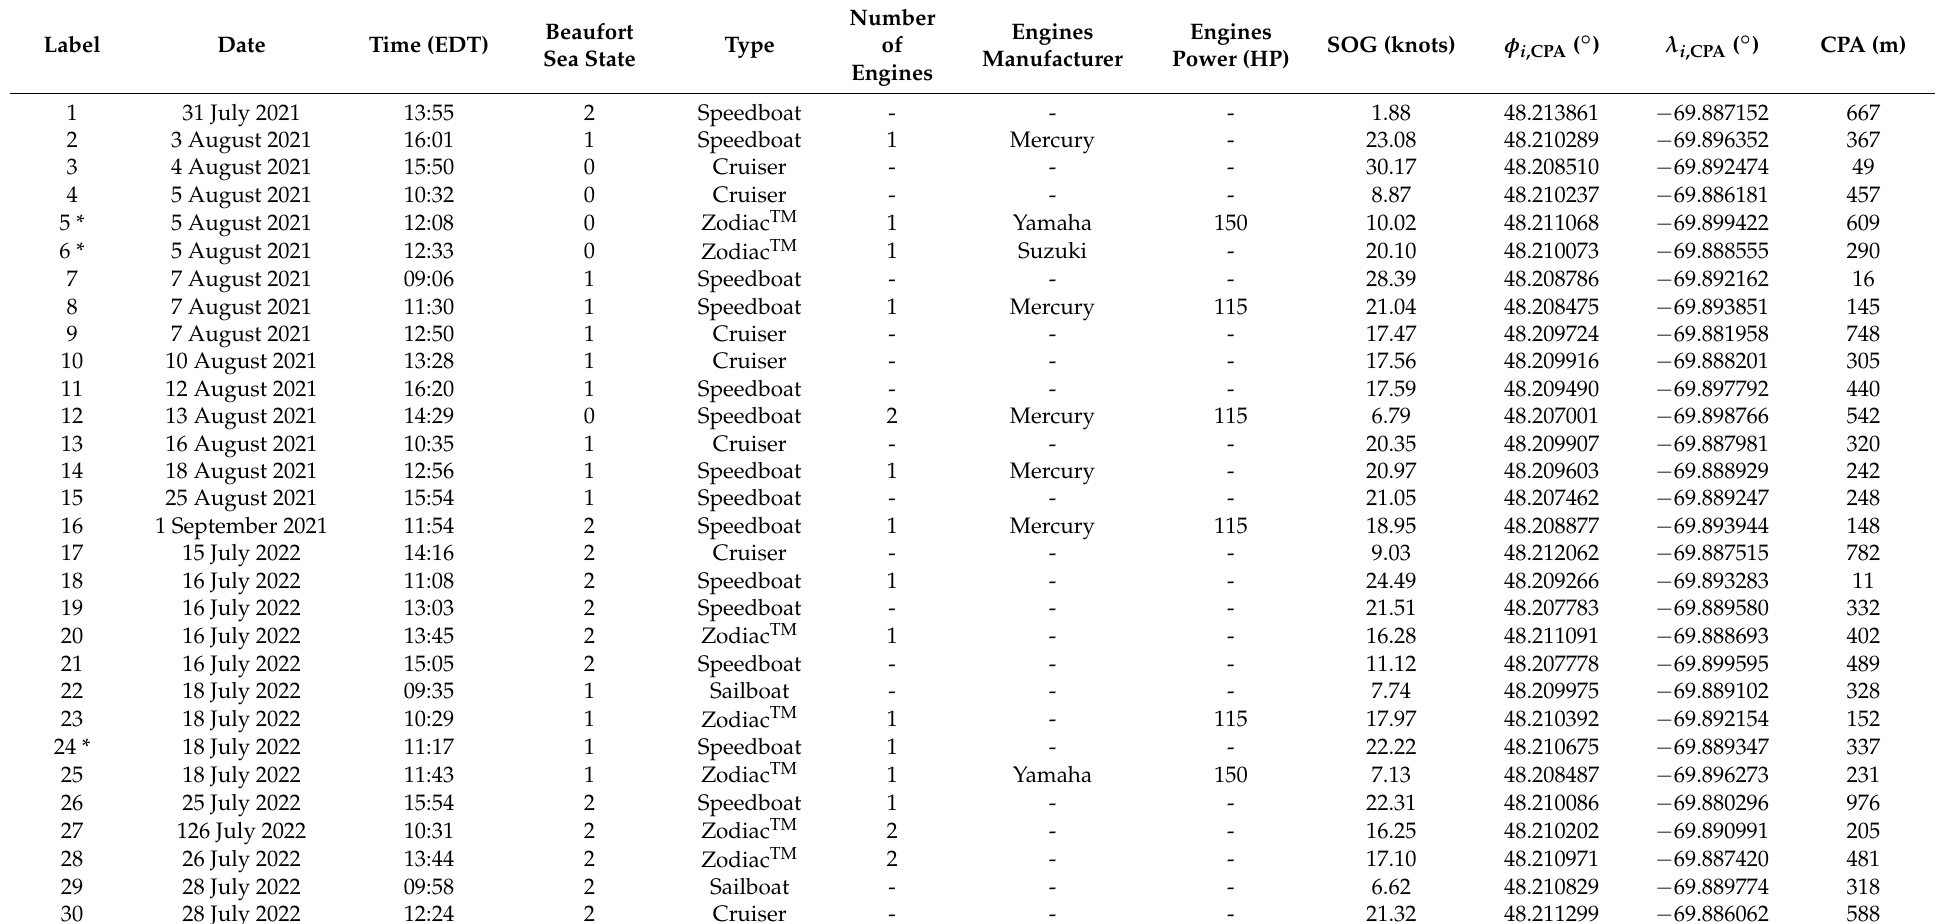
Table 1. Shore-based Observations of Isolated Small Recreational Vessels. Col. 1: vessel’s ID; same as trajectories in Figure 1. Col. 2: date of the observation. Col. 3: local time of the observation. Col. 4: local sea state. Col. 5: type of vessel. Cols. 6 to 8: number, manufacturer, and total power of engines. Col. 9: vessel’s speed over ground. Cols. 10 and 11: latitude and longitude of the vessel at the CPA. Col. 12: vessel-to-hydrophone distance at the